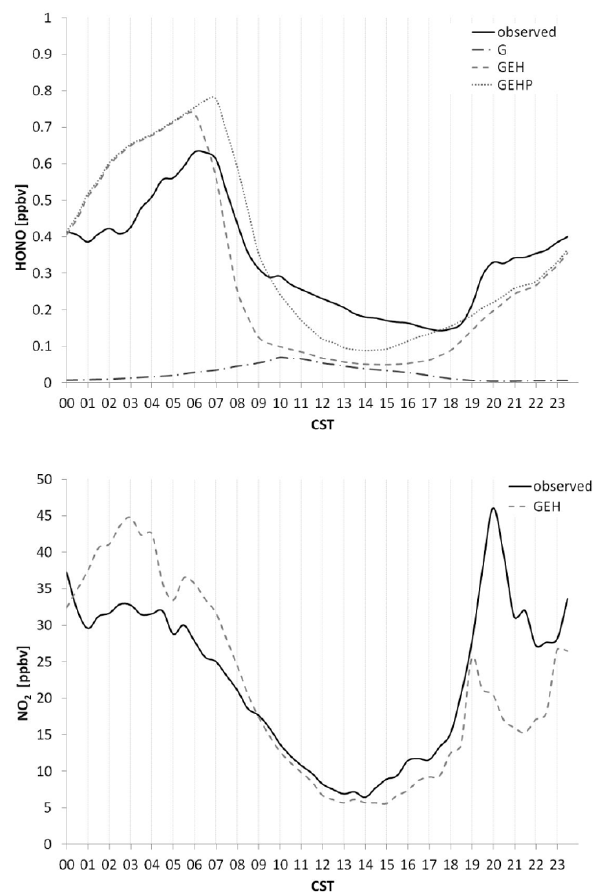
Fig. 2. Average diurnal variation of HONO (top) and NO 2 (bottom) based on data for 25 August–20 September 2006 at the top of the Moody Tower, at 60ma.g.l. Measured data obtained by